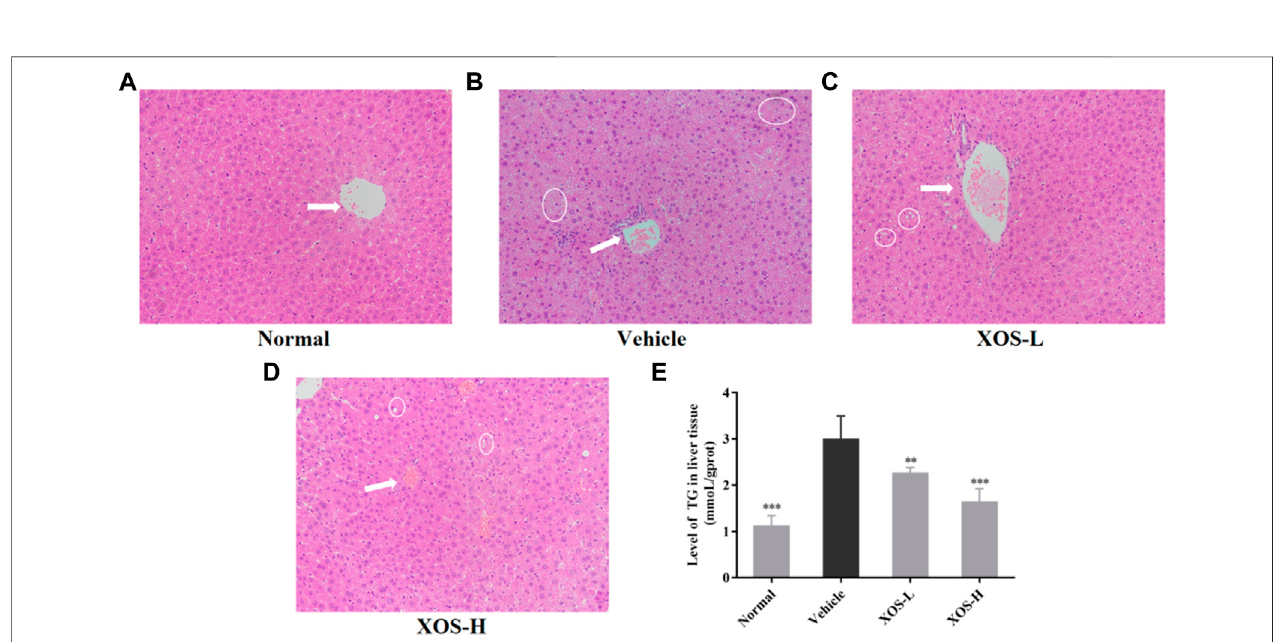
FIGURE3| EffectofXOSsupplementationonserumCytokineslevelinmice.XOS-L:micetreatwithXOS250 mg/kg,XOS-H:micetreatwithXOS500 mg/kg.* p < 0.05, ** p < 0.01, *** p < 0.001 compared with the Vehicle group.